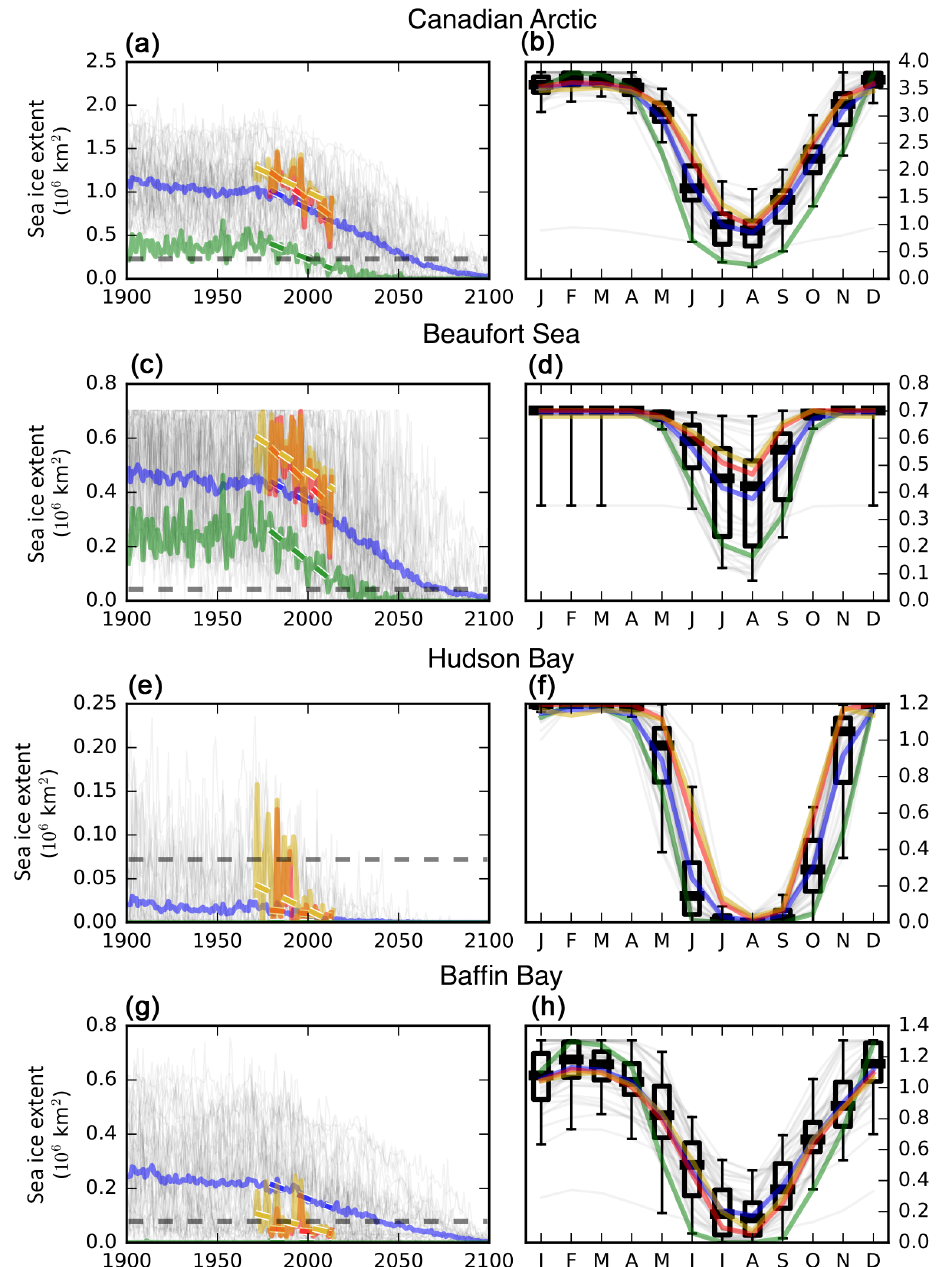
Figure 9. (a) September sea ice extent (sea ice concentration larger than 0.15) for the Canadian Arctic (defined by the Canadian Ice Service Data Archive (CISDA) domain). The CanESM2 model (green), CISDA (yellow), National Snow and Ice Data Center (NSIDC, red), and the multi-model mean (blue) are shown with their 1979–2013 trends. Individual models are shown in light grey. (b) The Canadian Arctic seasonal cycle for 1979–2013. Box plots were added to describe the inter-model spread (whiskers are 5th and 9th percentiles). Panels (c–d) , (e–f) , and (g–h) are the same as panels (a) and (b) but for the Beaufort Sea, Baffin Bay, and Hudson Bay, respectively. In panels (e) and (g) , the CanESM2 curve is close to zero. Sea ice amounts are scaled to account for the fraction of ocean present in the CanESM2 land–sea mask (Laliberté et al.,